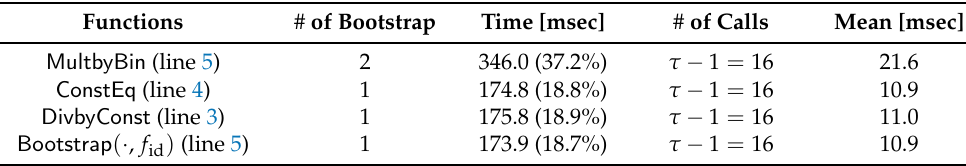
Table 3. A breakdown of the run time of our Div (Algorithm